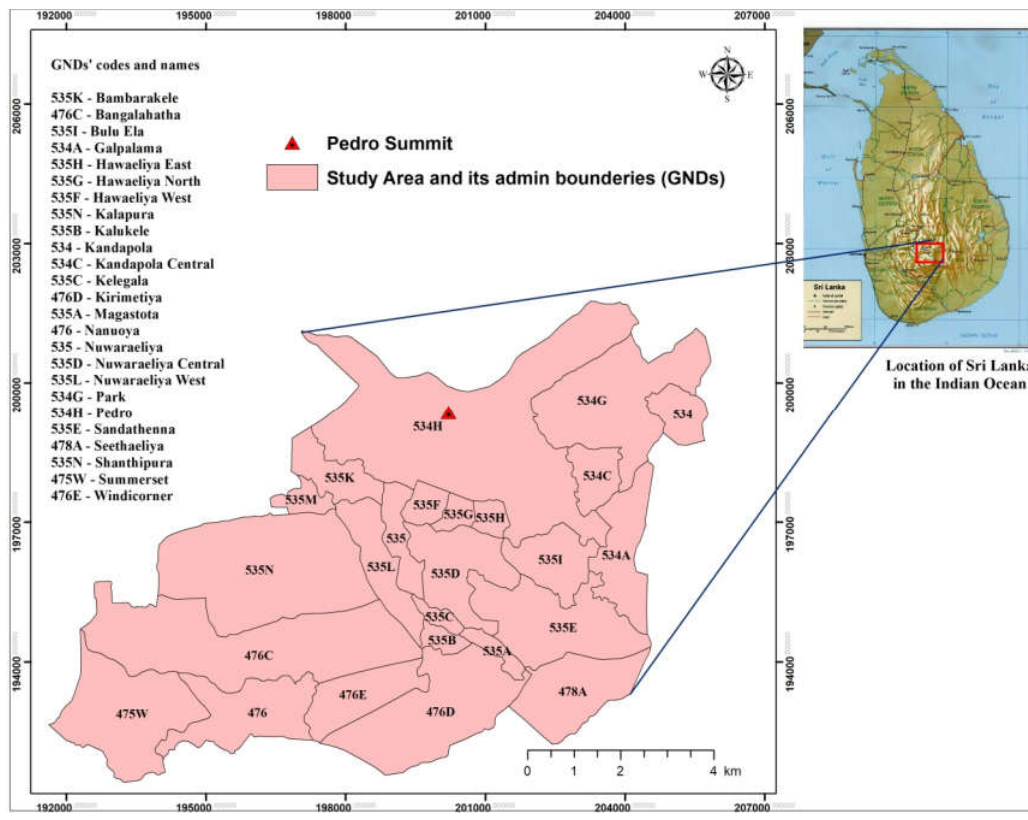
Figure 1. Upper part of Nuwara Eliya DSD and administrative divisions.